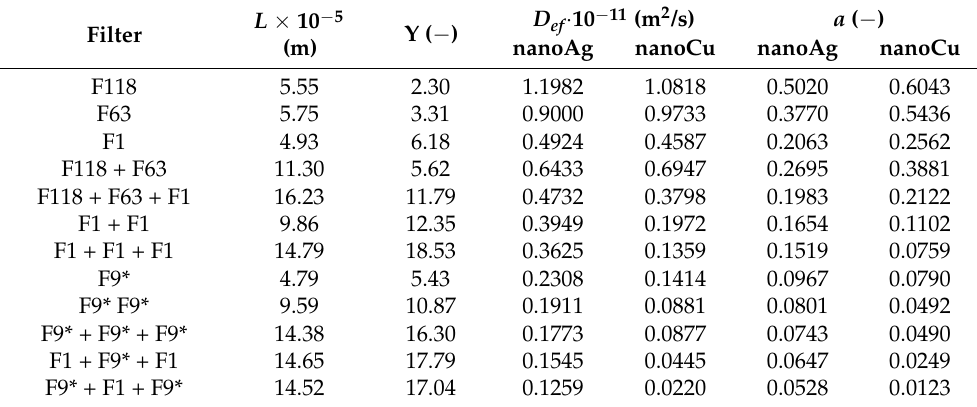
Table 1. Summary of calculations for nanoparticle